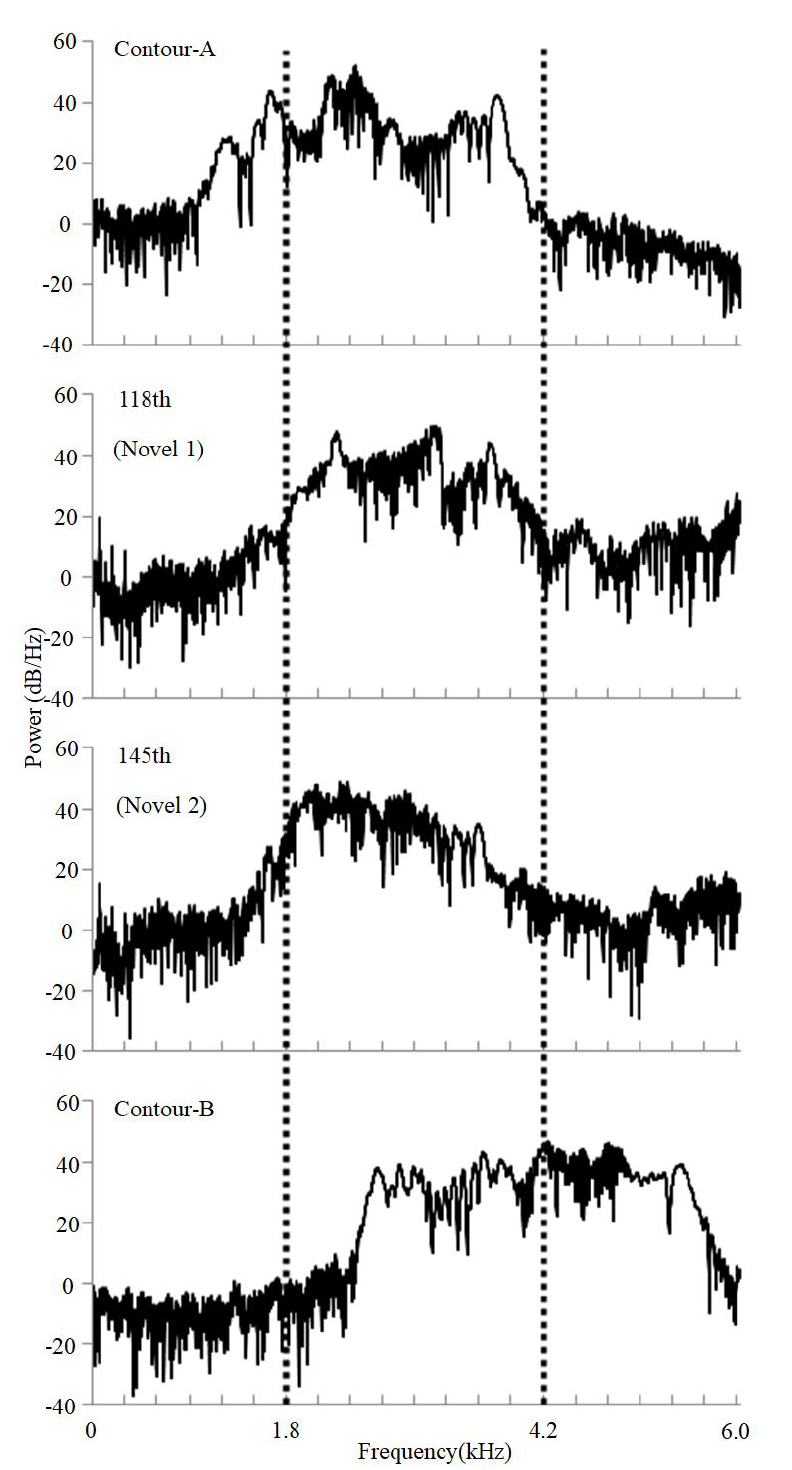
Figure 5 . Power spectrums of the playback sounds (contour-A and B) and vocalizations (novel patterns 1 and 2) the vocal patterns shown in Figure 3 (after normalizing in the total energy). Peak power of the novel patterns appeared in the middle frequency range between contour-A and